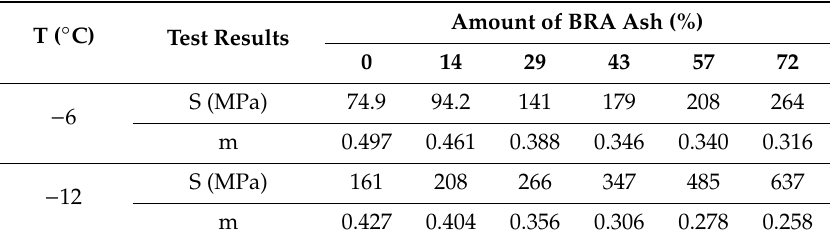
Table 16. BBR test results of BRA ash asphalt